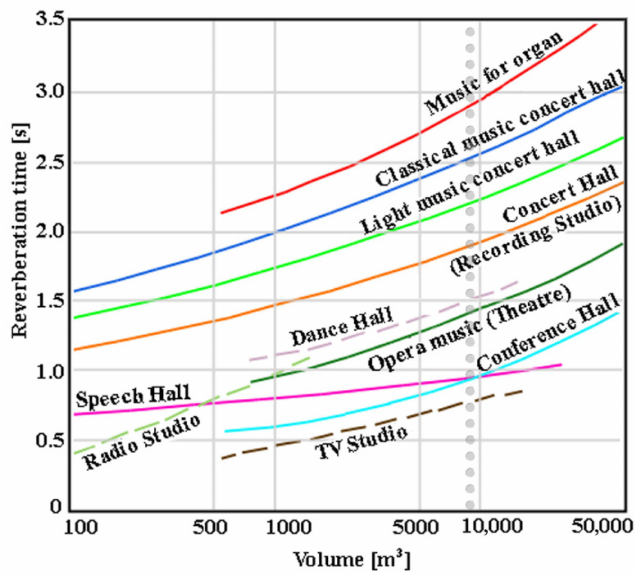
Figure 6. Optimal reverberation times as a function of the internal volume and the intended